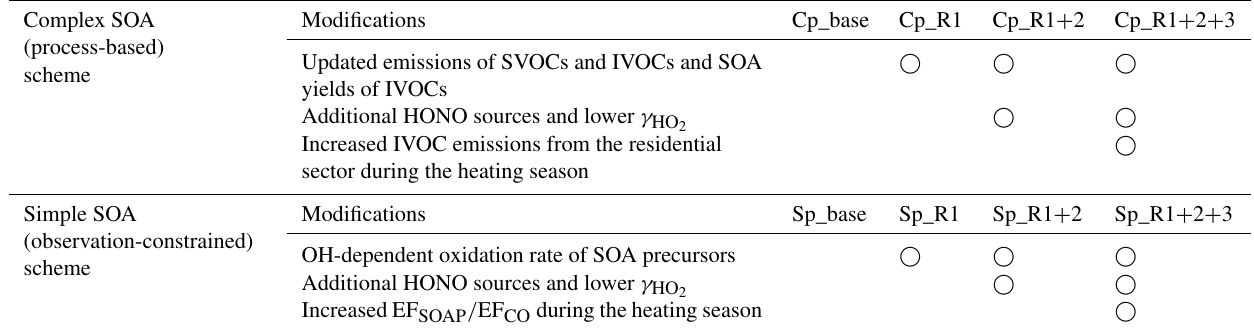
Table 1. Descriptions of the OA simulations in this study. Additional HONO sources include direct emissions from traffic, soil, and biomass burning as well as secondary formation from the heterogeneous reaction of NO 2 on the ground and the photolysis of nitrate. Complex